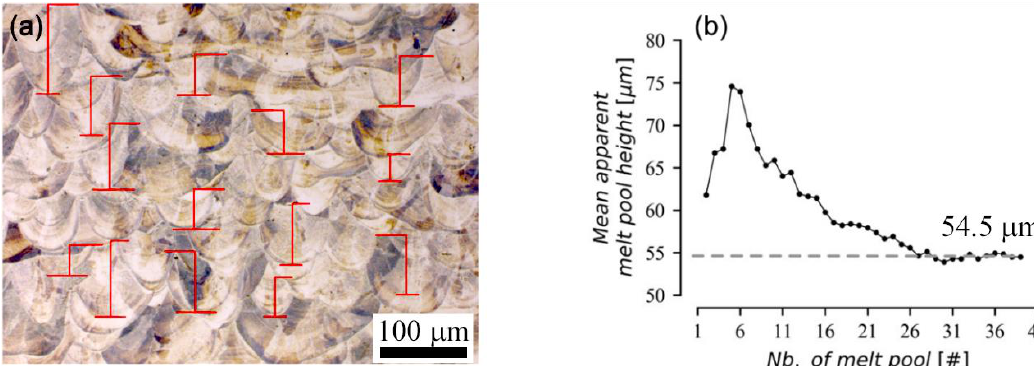
Figure 1. Selective laser melting SLM processed specimens melt pool size ( a ) cross-sectional optical image in build direction, melt pools shown with red line ( b ) mean apparent melt pool height vs. number of melt pools (# is the number of melt pool).